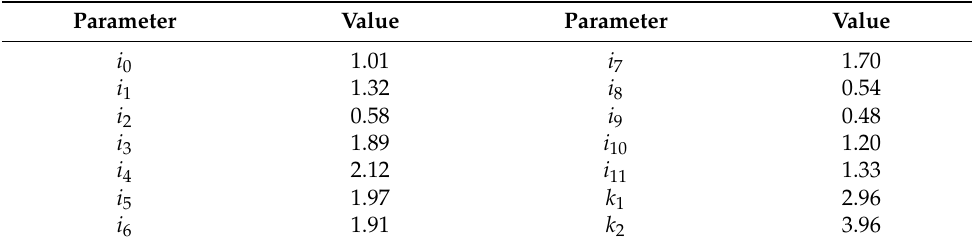
Table 5. Gearbox gear pair transmission ratio and k value.